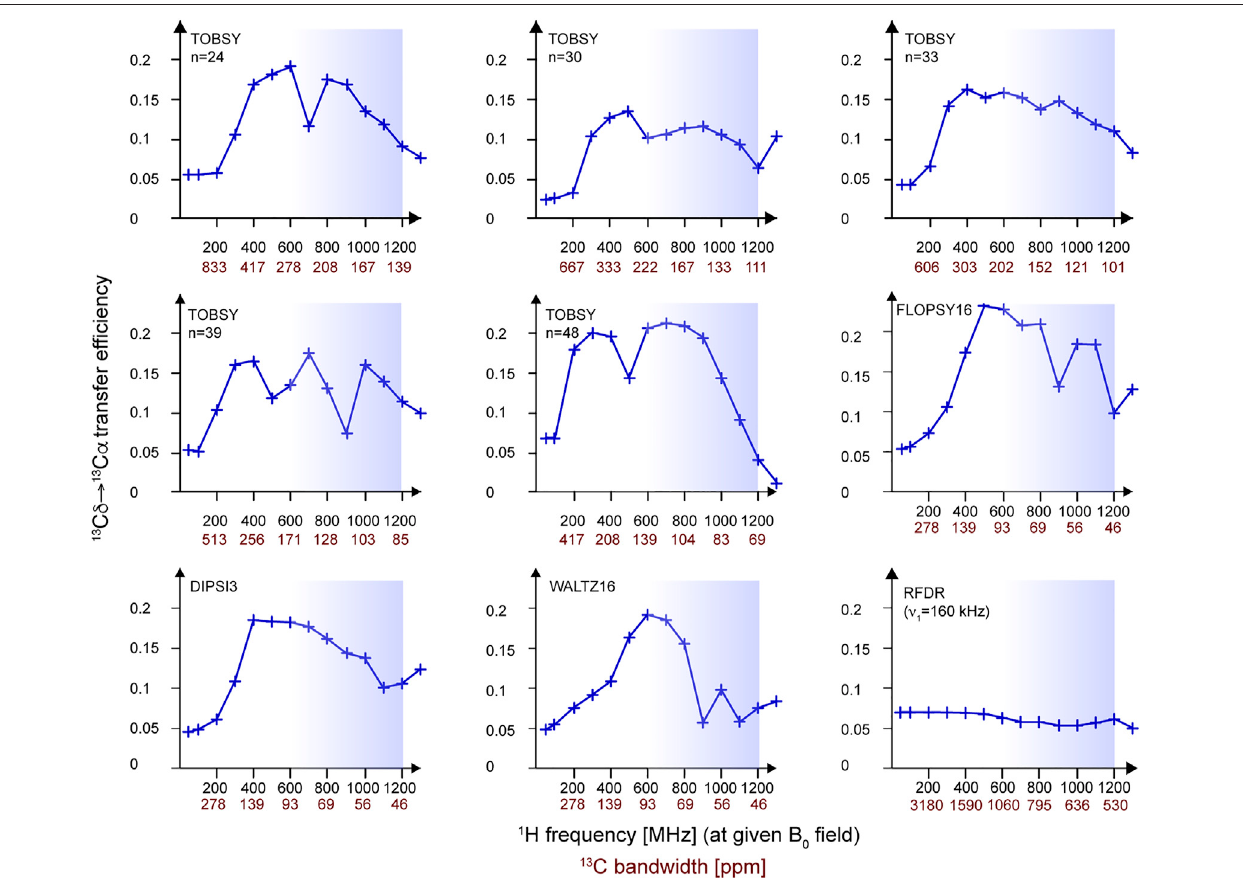
FIGURE 7 | Ef fi ciency of C δ 1 → C α transfer in a 13 C 6 spin system simulated in SIMPSON for a range of magnetic fi elds B 0 (corresponding to 1 H frequency between 50 and 1,300 MHz), MAS frequency of 55.5 kHz, and a constant RF strength of ν 1 = ¼ ν R ≈ 13.9 kHz. Note that, in essence, the dependence on 13 C bandwidth ( ν 1 expressedin 13 C ppm)ofaparticularmixingisinvestigatedhere.Foreach B 0 point,afullbuildupwasperformed,andanoptimumwaspickedatthemixingtimesthatare reported in Supplementary Figure S9 . All RF schemes except the particularly computationally demanding DREAM were evaluated. Blue boxes indicate the B 0 fi eld range available for 1 H-detected MAS NMR at